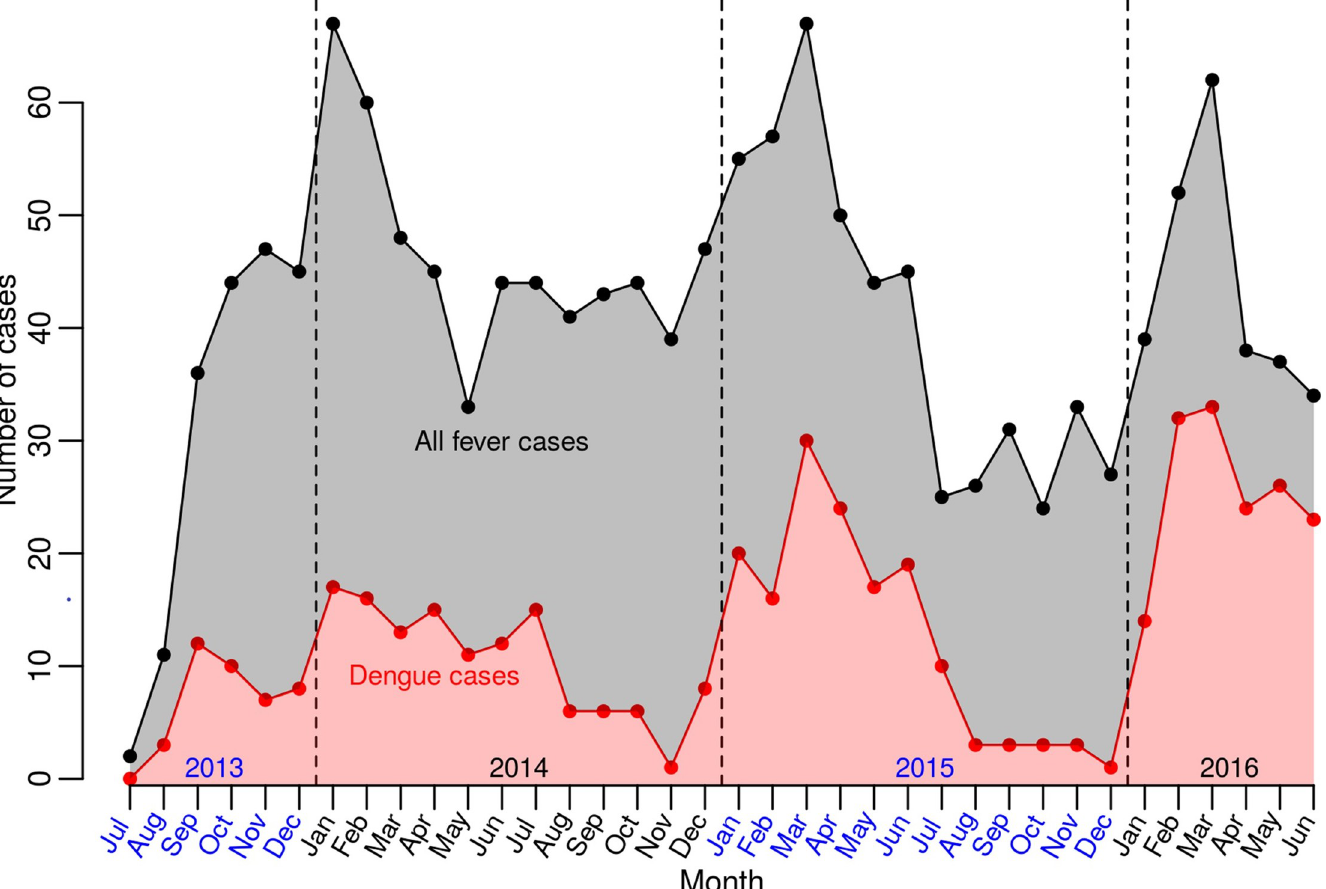
Fig 2. Dengue cases per month. Red dots/area: dengue cases. Black dots/gray area: all fever cases.